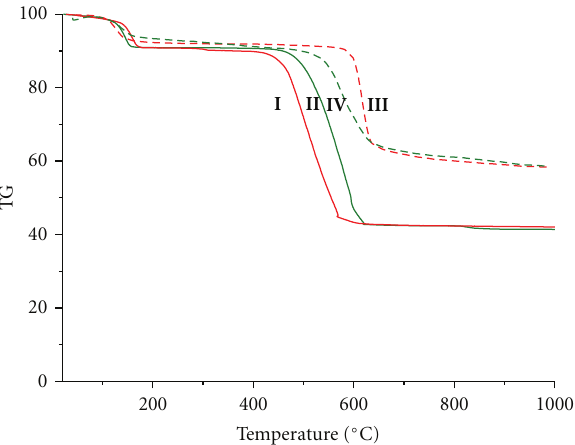
Figure 7: Thermogravimetric curves of Ln 2 (Carb (cid:2) ) 3 (H 2 O) n ( I – IV ).